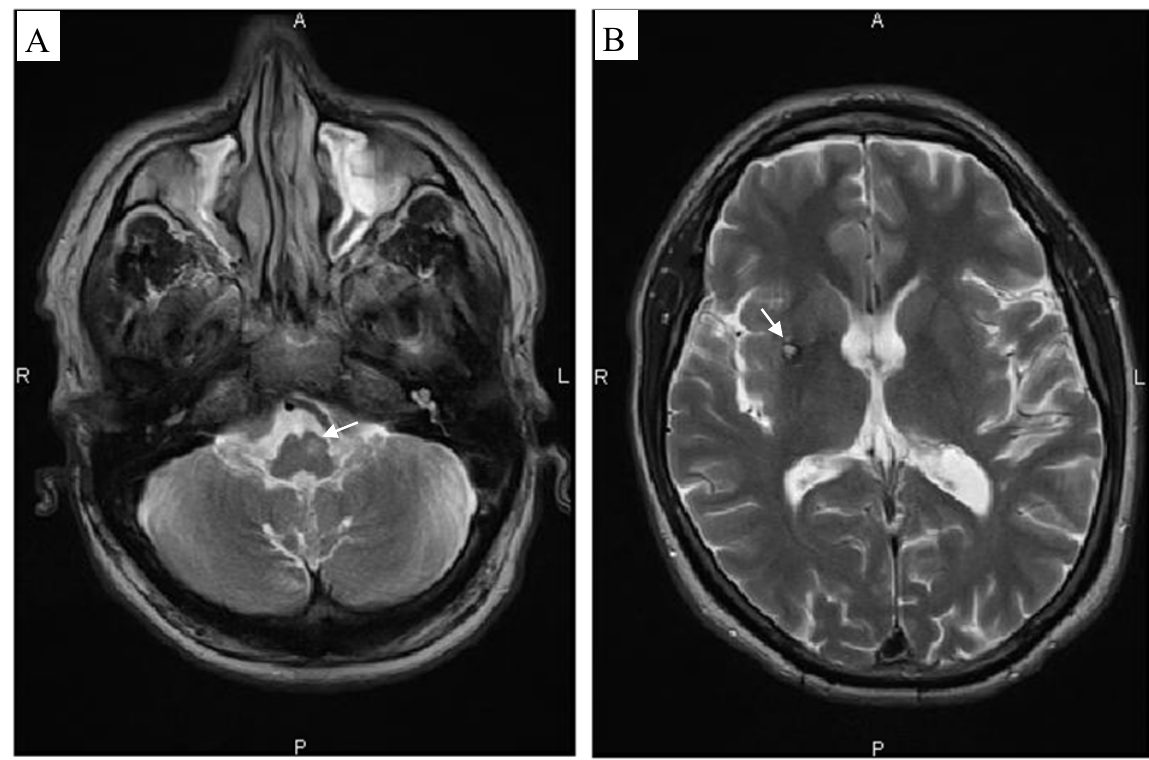
Figure 2. Brain MRI of a patient exhibiting a disabling neurological tremor in the upper limbs. Note the left inferior olivary hypertrophy (Guillain-Mollaret triangle; arrow in left panel, (A) and the lesion in putamen (arrow in right panel, (B) . Axial T2-weighted images. R: right, L: